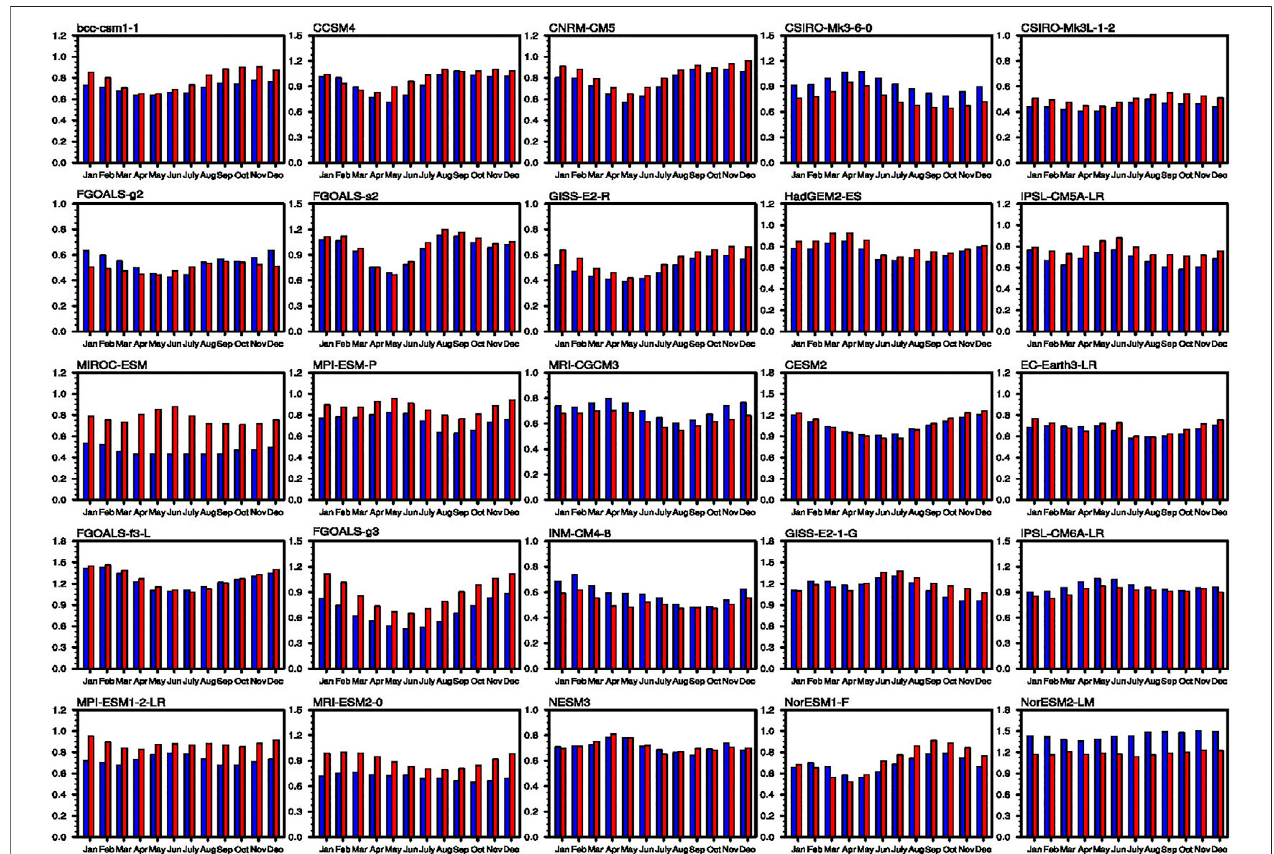
FIGURE 6 | Monthly STD of SST anomalies in the equatorial Paci fi c (160 o E – 90 o W, 5 o S – 5 o N) for the PI (blue bar) and MH (red bar) simulations from PMIP3 and PMIP4 models. Unit is K.